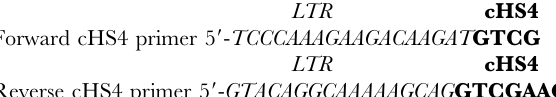
Table S1 List of primer sequences used in PCR reactions for construction of LCR b / c -globin transgenes and lentiviral vectors.